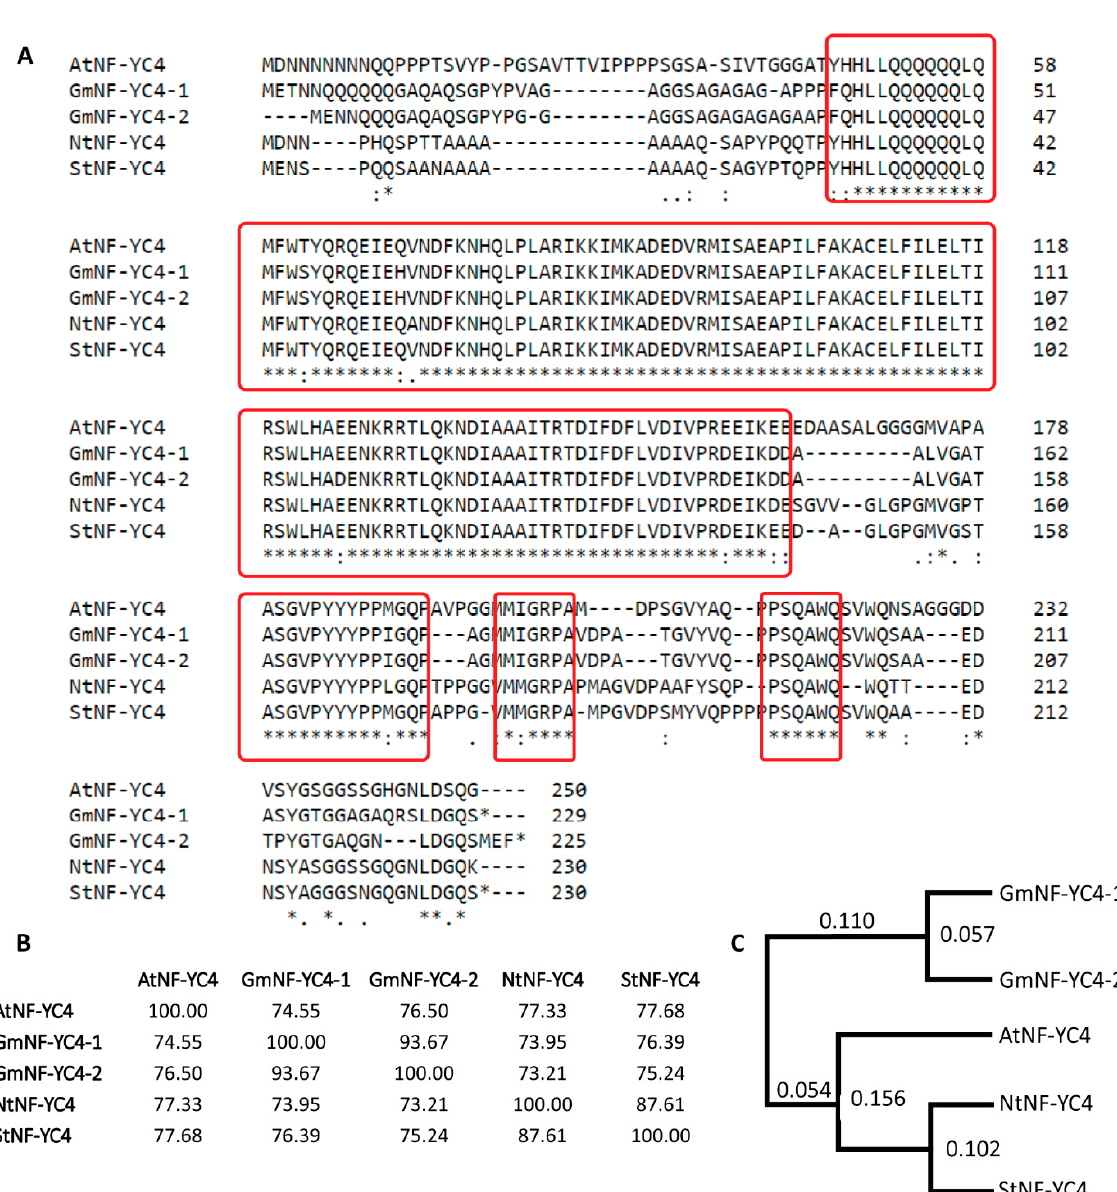
Figure 5. Sequence similarity of StNF-YC4 to other NF-YC4 homologs from different species. ( A ) Protein sequence alignment of StNF-YC4 with homologs in A. thaliana (AtNF-YC4), soybean (GmNF-YC4-1 and GmNF-YC4-2), and tobacco NtNF-YC4. Conserved sequences are outlined in red. The “*” at the end of the StNF-YC4, GmNF-YC4-1, and GmNF-YC4-2 sequences signify a stop codon. “*“ under the amino acid sequence indicates positions with a single, fully conserved residue, “:” indicates conservation between groups of strongly similar properties (scoring > 0.5 in the Gonnet PAM 250 matrix), and “.” indicates conservation between groups of weakly similar properties (roughly equivalent to scoring ≤ 0.5 and >0 in the Gonnet PAM 250 matrix). ( B ) A percent identity matrix shows similarities among the NF-YC4 proteins in A. thaliana , soybean, and tobacco peptide sequences. The matrix was created by Clustal 2.1 [47]. ( C ) A maximum-likelihood tree for the NF-YC proteins in A. thaliana , soybean, tobacco, and potato. A blastp search was performed using the AtNF-YC4 amino acid sequence as the query, and the top match from S. tuberosum was selected for the tree. Branch lengths were measured in the number of substitutions per site.